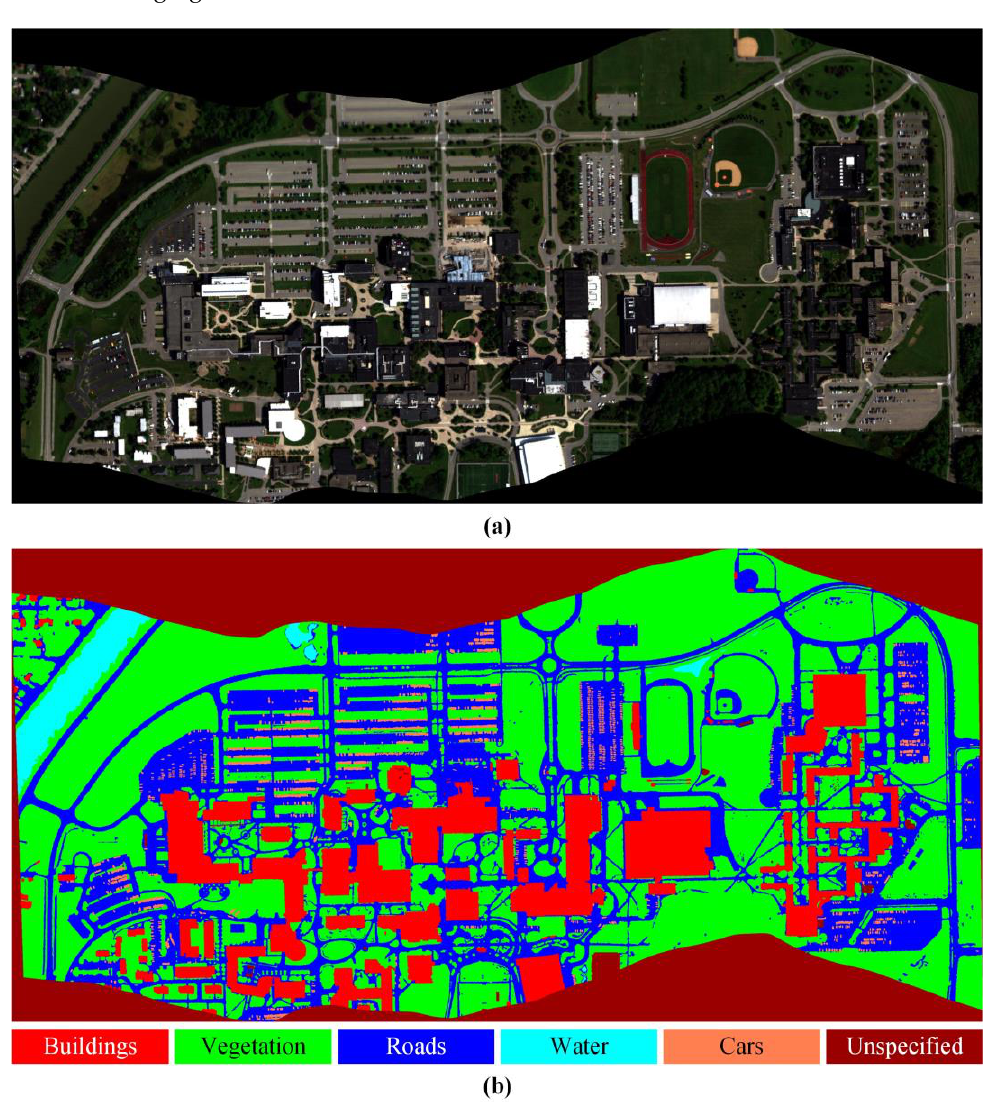
Figure 1. The AeroRIT scene. ( a ) RGB image; ( b ) Ground-truth classification map.